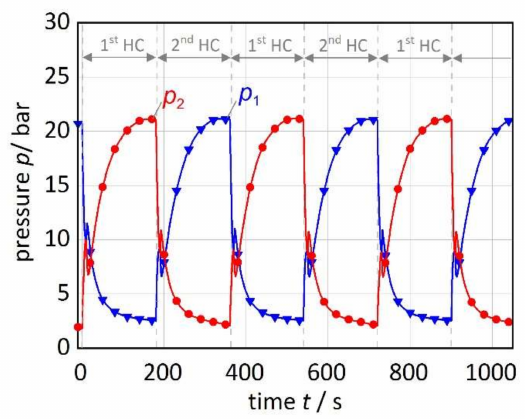
Figure 7. Transient course of the pressures of reactor pairs 1 and 2 for reference conditions.